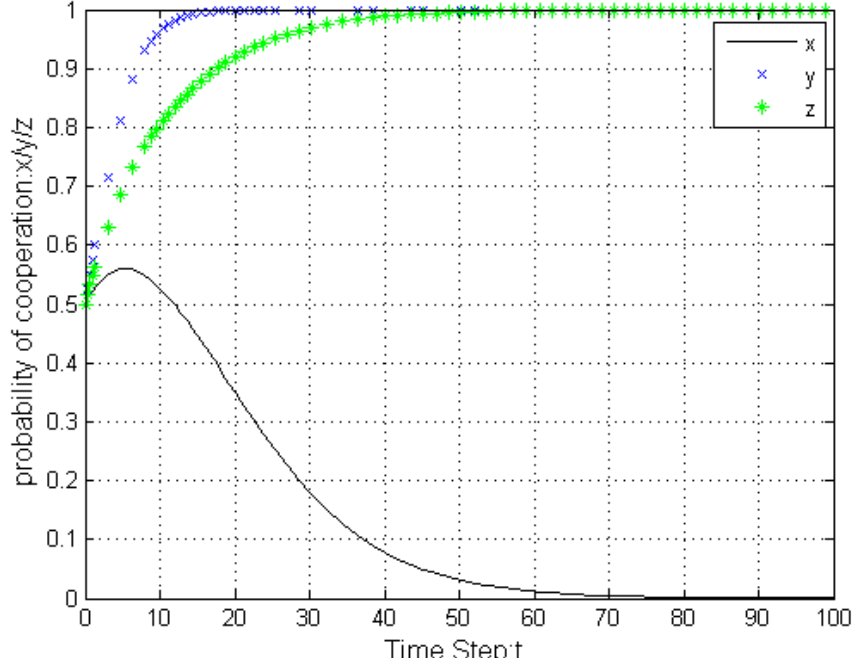
Figure 7. Evolution simulation, Scenario 7.